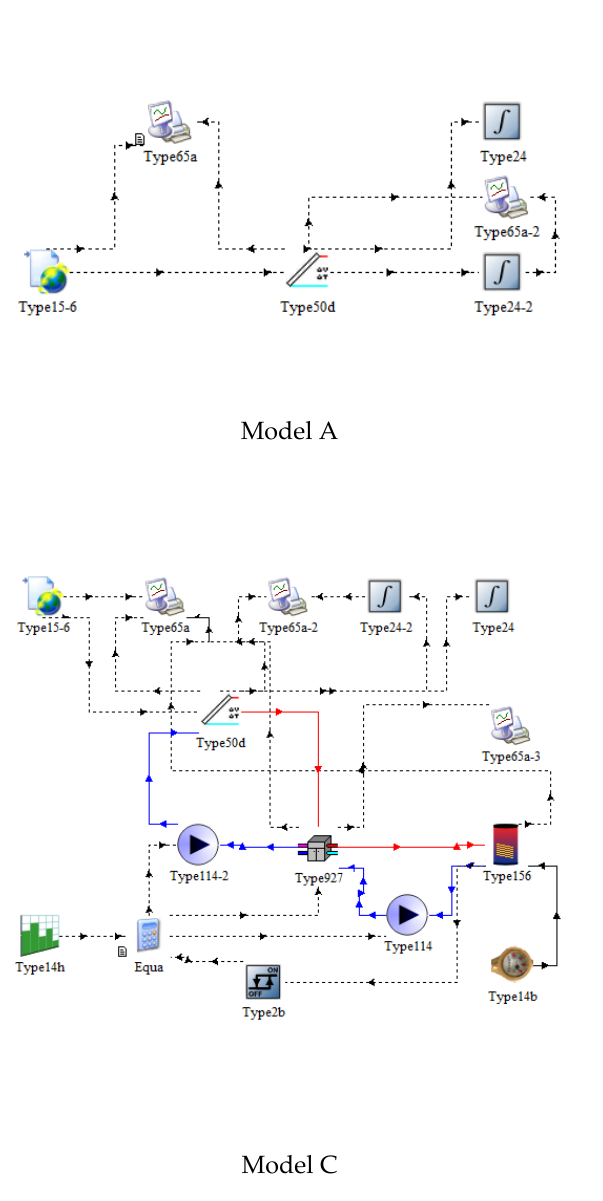
Figure 2. TRNSYS models of analyzed systems.